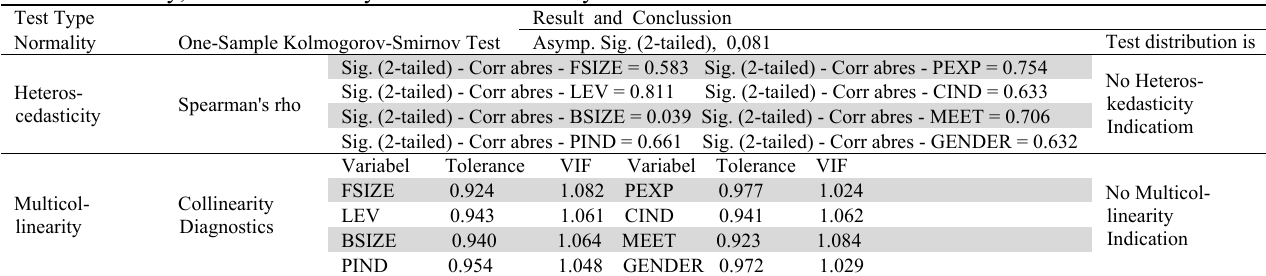
Test of Normality, Heteroscedasticity and Multicollinearity